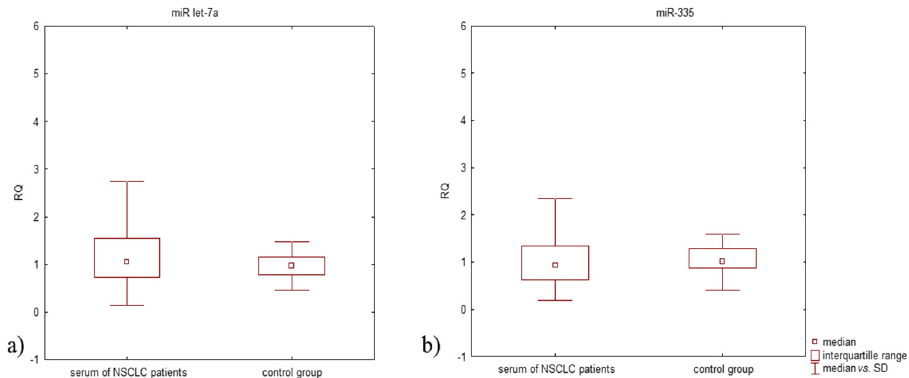
Figure 3. Box plot showing differences in median RQ values for ( a ) miR let-7a, ( b ) miR-335 in the serum of NSCLC patients and in the control group (U-Mann-Whitney test).